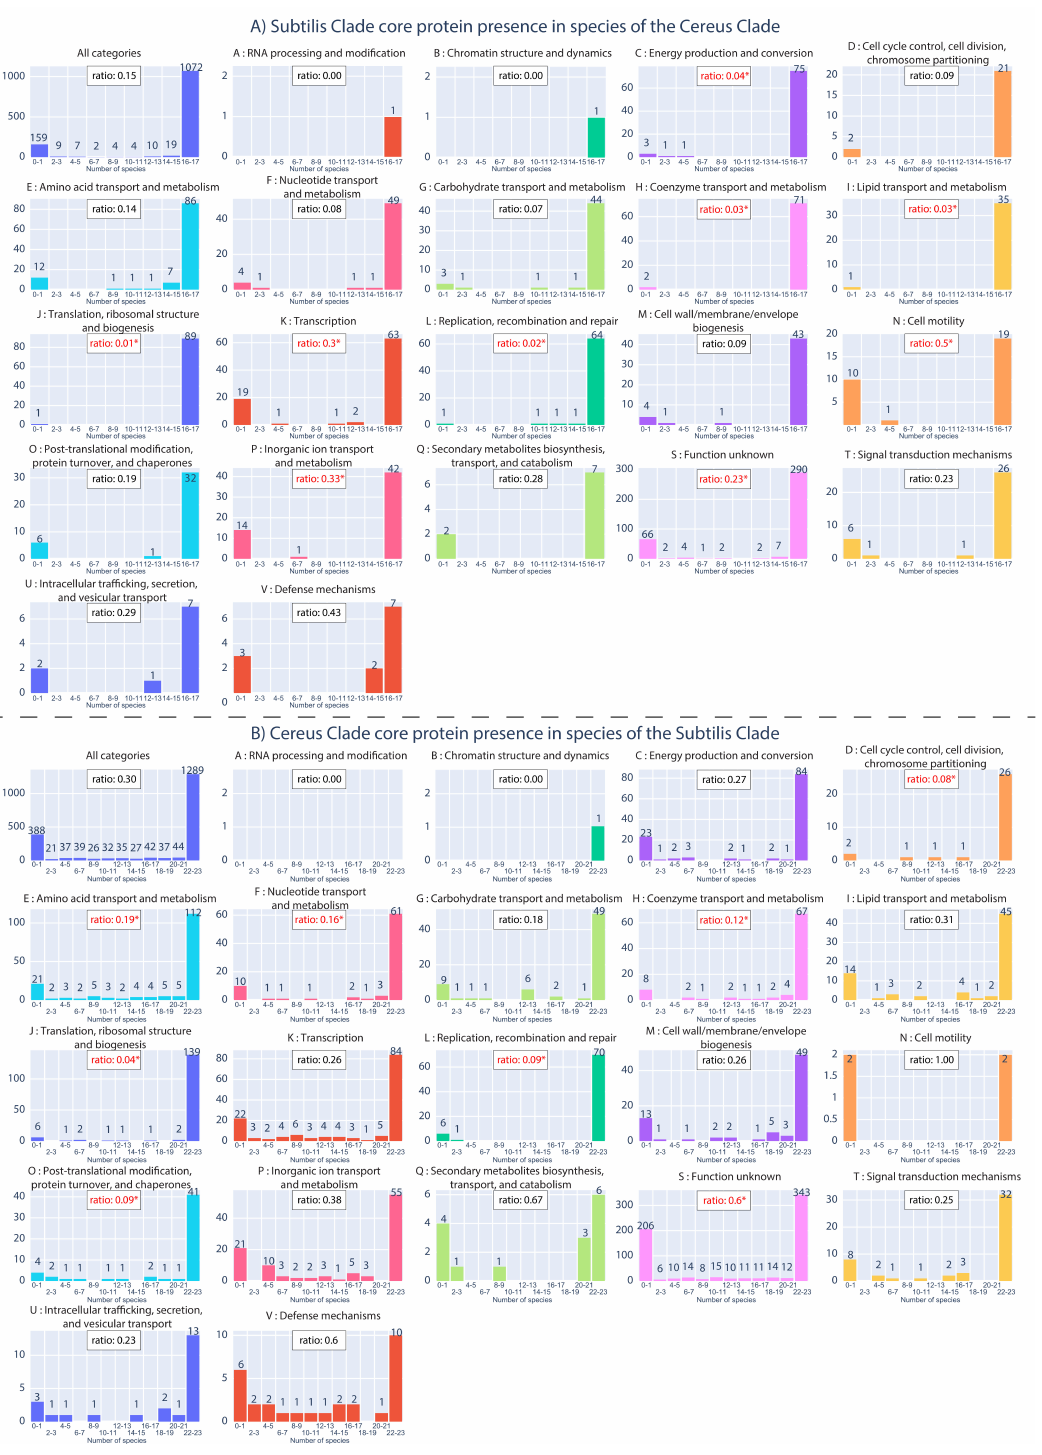
Figure 5. ( A ) The phylogenetic distribution of core proteins of the Subtilis Clade in the species of the Cereus Clade. ( B ) The phylogenetic distribution of core proteins of the Cereus Clade in the species of the Subtilis Clade. The bins on the x-axis correspond to the number of species (in the other Clade), while the y-axis corresponds to the absolute number of core proteins (for that bin). For example, the first graph of Figure 5A shows that 1072 of the core proteins of the Subtilis Clade are also present in 16–17 species of the Cereus Clade. The ratio of the low-presence to high presence bin is shown in the box at the top of the graph. Stars identify any ratio whose difference from the background (in all categories) is statistically significant (based on the hypergeometric test; p -value <